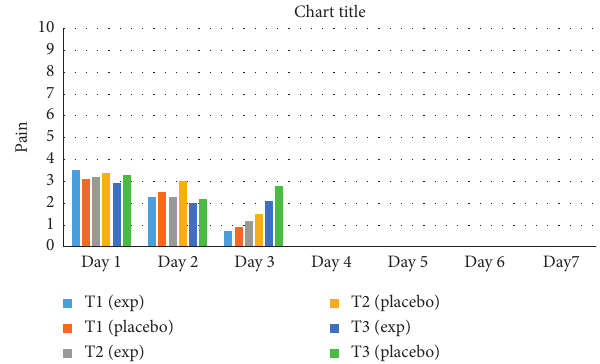
Figure 2: Comparison of pain among the experimental side and placebo side in group A at T1, T2, and